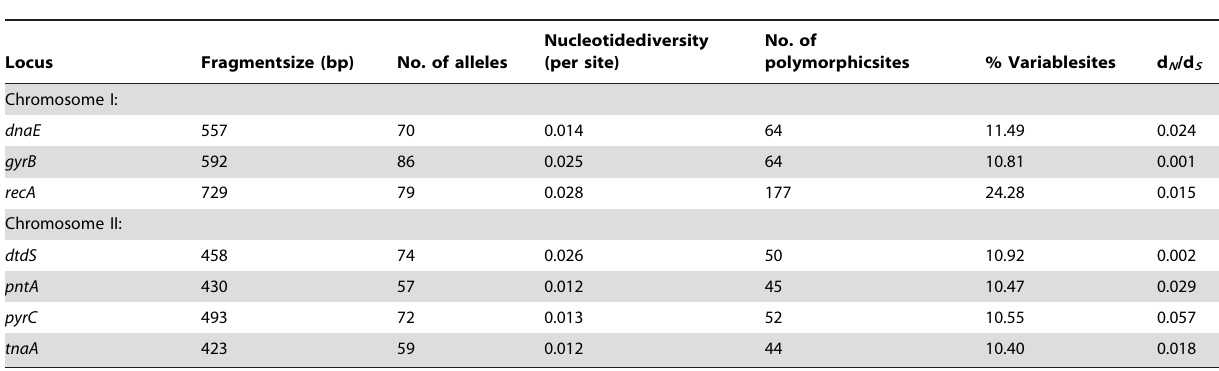
Table 1. Genetic Diversity of the Seven Loci in 490 Vibrio parahaemolyticus Isolates.